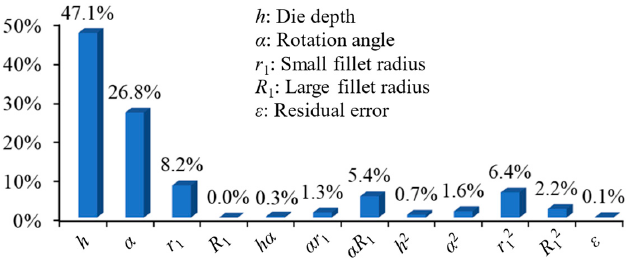
Figure 9. Percentage contribution of different parameters for shearing strength.